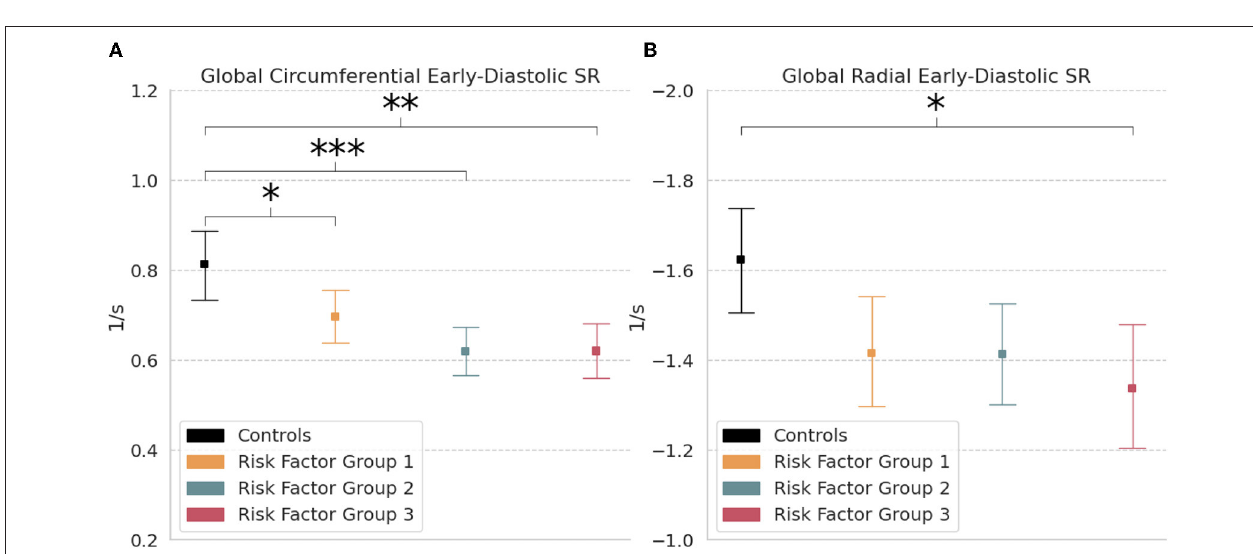
asymptomatic diastolic dysfunction may occur early in the pathogenesis of T2DM, and accumulate gradually over time